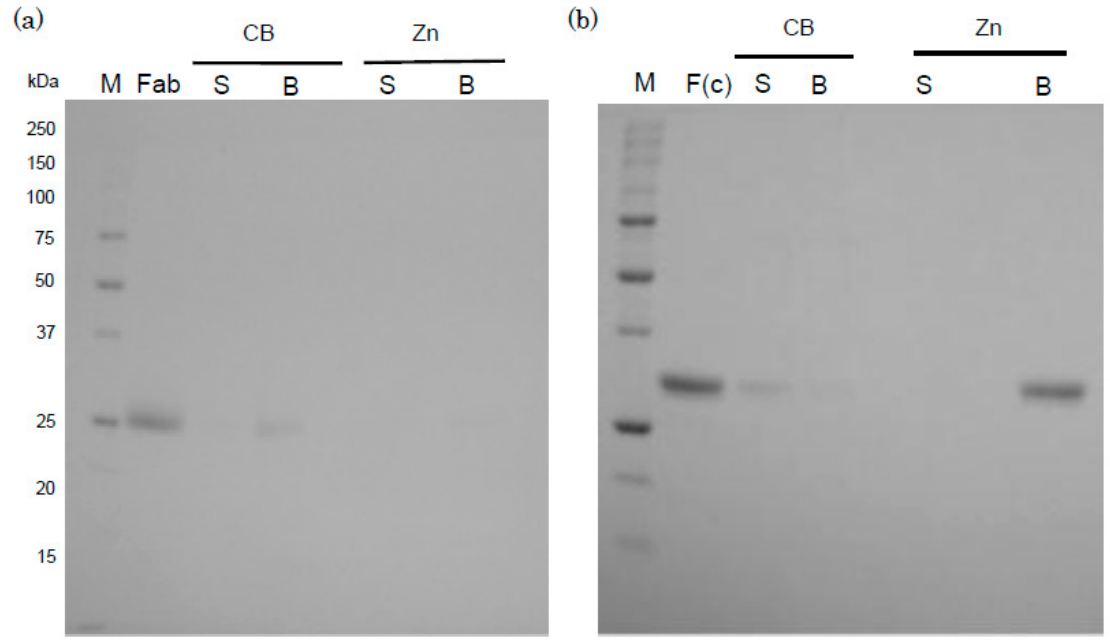
Figure 3. The binding of human IgG Fab ( a ) and F(c) fragments ( b ) to Zn-beads. Aliquots (1 mL) of each fragment (25 µg) and Zn-beads or CB in PBS were prepared (net volume of beads per sample: 20 µL each), and incubated at 4 °C overnight. The mixtures were centrifuged at 14,000× g for 7 min, and the supernatant and pelleted beads were subjected to SDS-PAGE as described in the “Experimental Section”. Supernatant (S) and pelleted beads (B) from respective CB and Zn-beads (Zn) incubated with Fab ( a ) and F(c) ( b ) were applied to SDS-PSGE. Human IgG Fab and F(c) fragment samples were also applied to the gel (2 µg each/lane). M represents marker